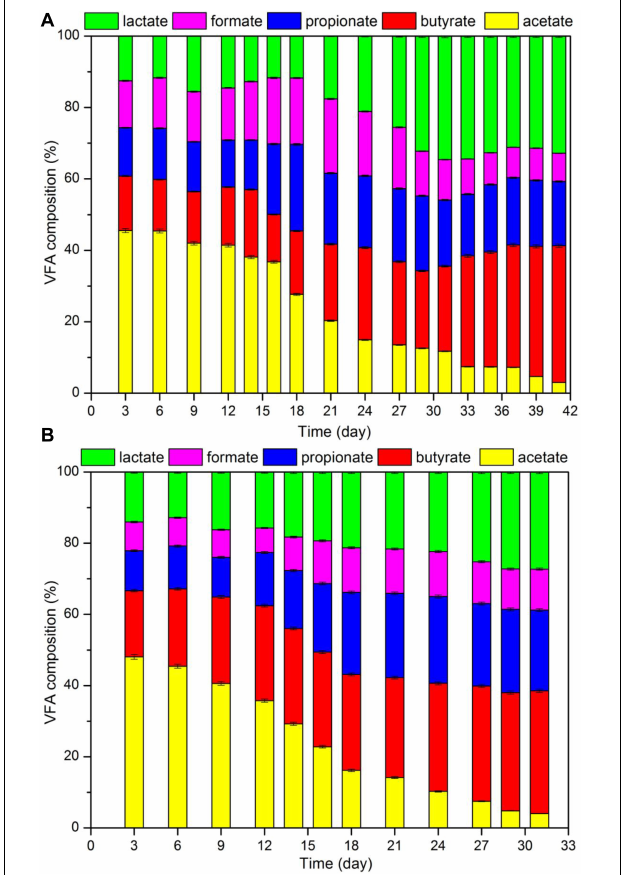
FIGURE 7 | Composition of VFA in the fermentation liquid during CSTR digestion of pork products after HTP: (A) reactor with hydrochar addition; (B) control